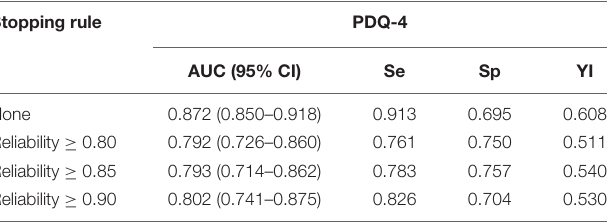
TABLE 6 | The predictive utility (sensitivity and specificity) of the CAT-SPD under different terminating rules.